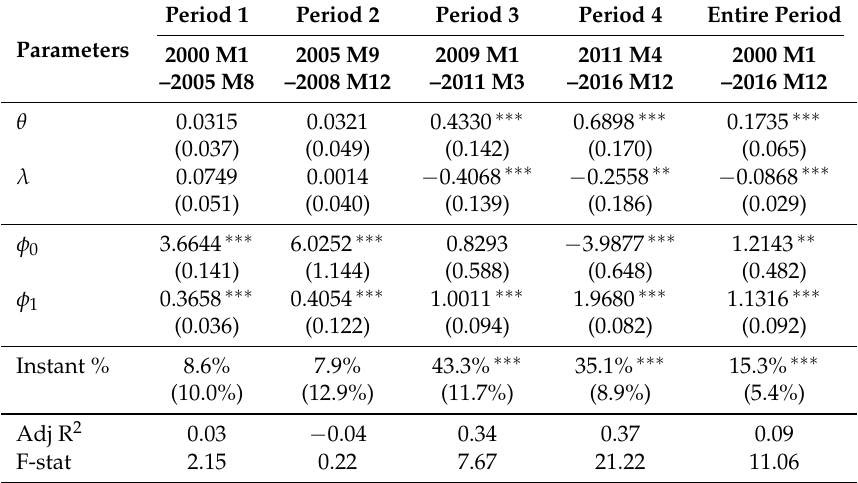
Table 4. Engle–Granger error correction models for ∆ p JKM and ∆ p NBP